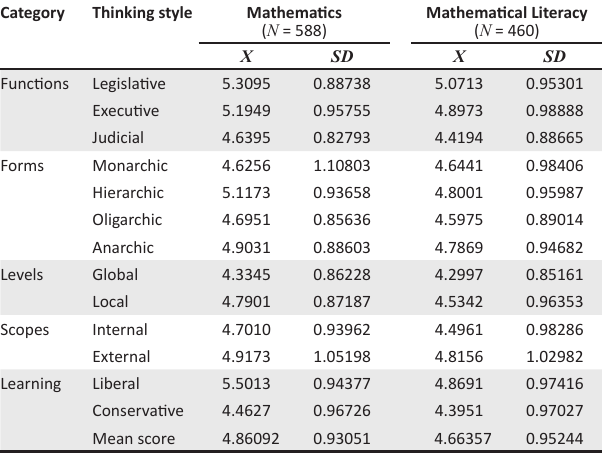
TABLE 5: Descriptive statistics pertaining to the thinking style dimensions of learners taking Mathematics and Mathematical Literacy. Category